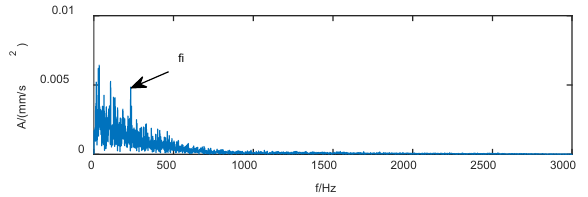
Figure 8. The envelope spectrum of IMF3.